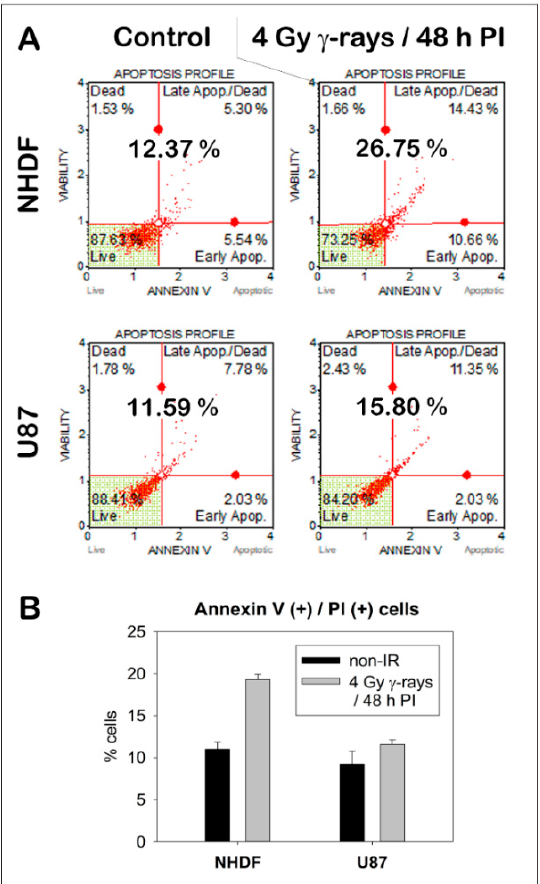
Figure 4. Cell death upon γ -irradiation compared for NHDF fibroblasts and U87 glioblastoma cells as quantified by flow cytometry 48 h post-irradiation (PI). ( A ) Illustrative flow-cytograms for NHDF and U87 cells prior to (left, control) and 48 h after irradiation with 4 Gy of γ -rays. x-axis: Annexin V positivity (a.u.); y-axis: propidium iodide (viability) positivity (a.u.); lower-left quarter (Annexin V ( − )/Propidium Iodide ( − )) = viable cells; lower right quarter (Annexin V (+)/Propidium Iodide ( − )) = early apoptosis; upper left quarter (Annexin V ( − )/Propidium Iodide (+)) = dead cells; upper right quarter (Annexin V (+)/Propidium Iodide (+)) = dead cells or late apoptosis shortly before dying. The total proportion of cells in the different quarters is given in percent of all cells measured. ( B ) Mean proportions ( ± standard deviation) of cells positive for Annexin V, Propidium Iodide (PI), or both these markers (white quarters in ( A )) before (black columns) and 48 h after (grey columns) exposure of cells to 4 Gy of γ -rays.